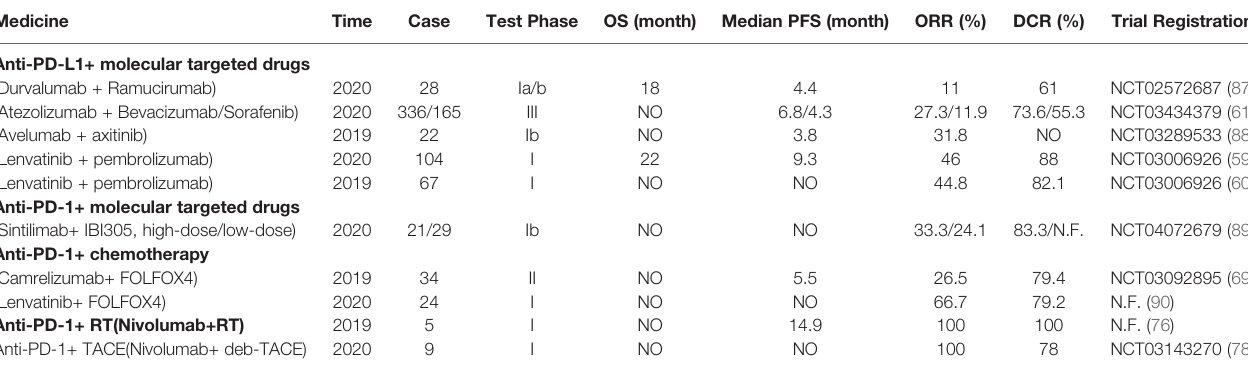
TABLE 2 | Partial research results of ICIs combined with other therapies to treat HCC